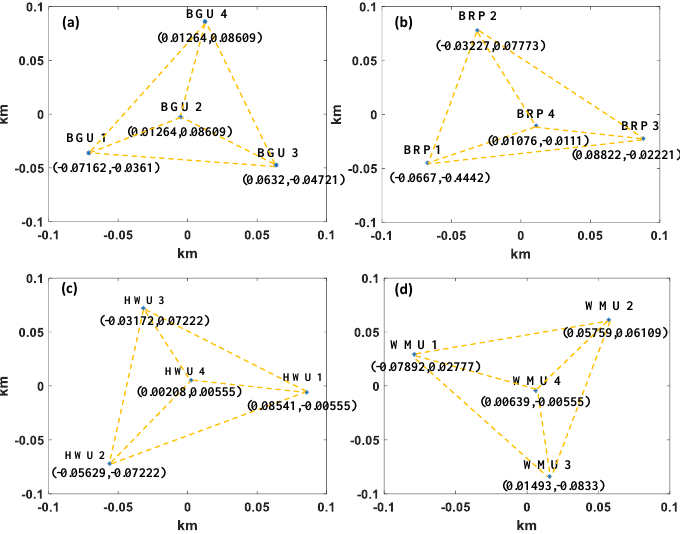
Figure 6. The array structures of BGU, BRP, HWU, and WMU are shown in ( a – d ), respectively. The time-domain waveforms of the four stations are shown in Figure 7. The intercep- tion of the infrasound signals recorded at each station is selected as follows for each station. The BGU station intercepts 20 s signal as well as the sensor selections BGU1 and BGU3, and the array aperture is 135 m; the BRP station intercepts the 30 s signal as well as the sensor selections BRP1 and BRP3, and array aperture is 150 m; the HWU station intercepts the 100 seconds signal as well as the sensor selections HWU1 and HWU3, and the array aperture is 140 m; and the WMU station intercepts the 15 s signal as well as the sensor selections WMU2 and WMU3, and array aperture is 150 m . The intercepted infrasound is substituted into the SBL algorithm to obtain the azimuth information of the four stations. The infrasound signal and the SBL algorithm parameter setting are shown in Table